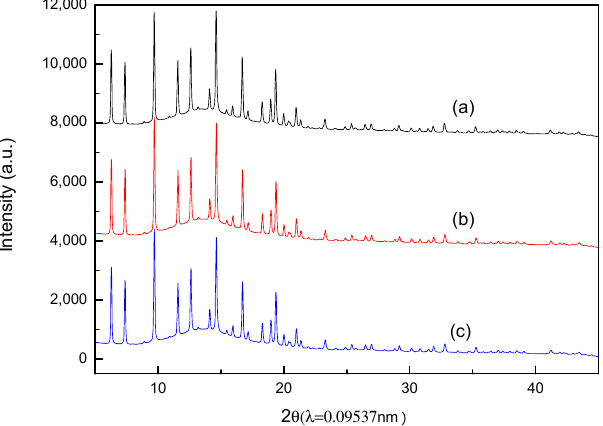
Figure 7. Powder X-ray spectra of (a) fresh Pt/NaY-SiO 2 , (b) PtR (HF) , (c) PtR (LF) .